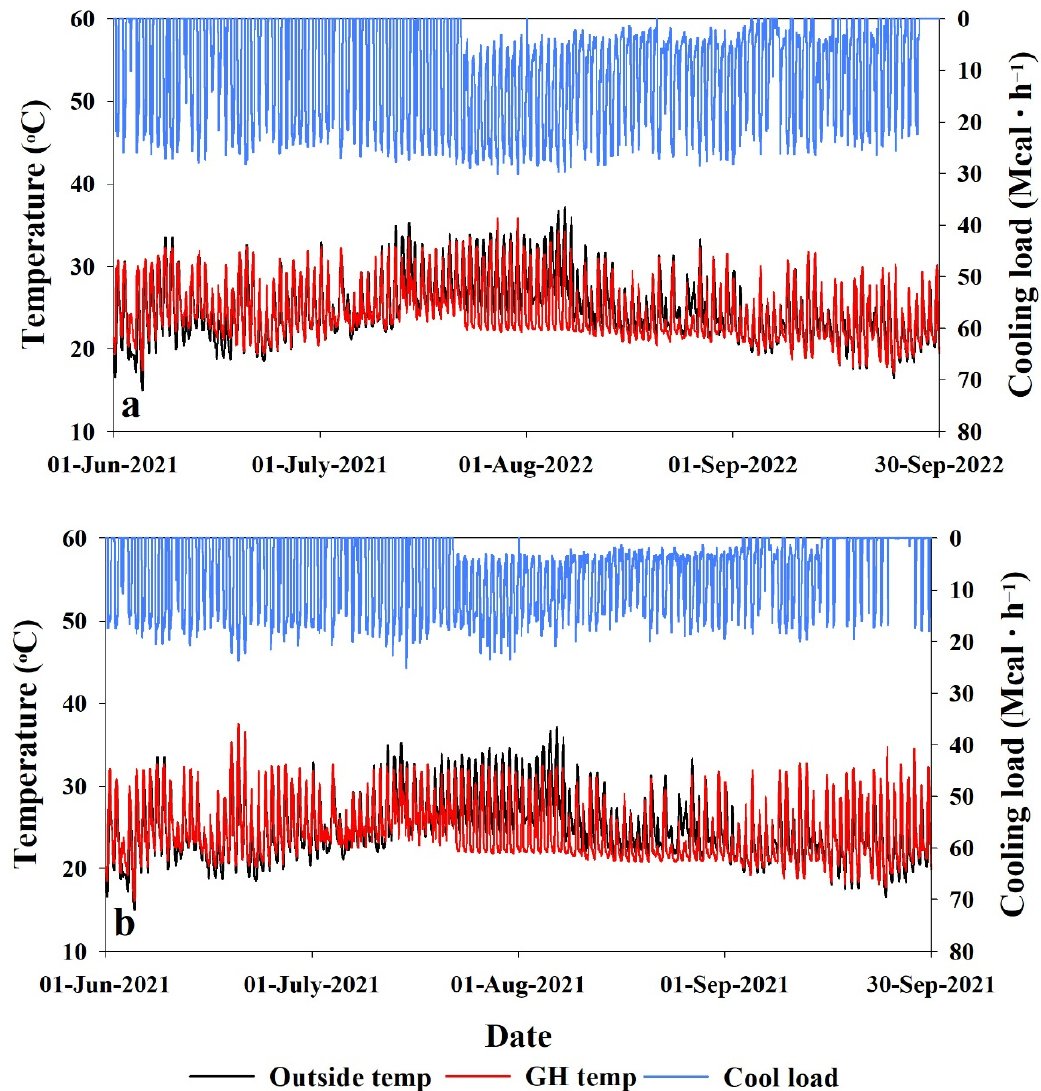
Figure 10. Greenhouse cool load with ambient weather air temperature in ( a ) June, ( b ) July, ( c ) Au- gust, and ( d ) September.